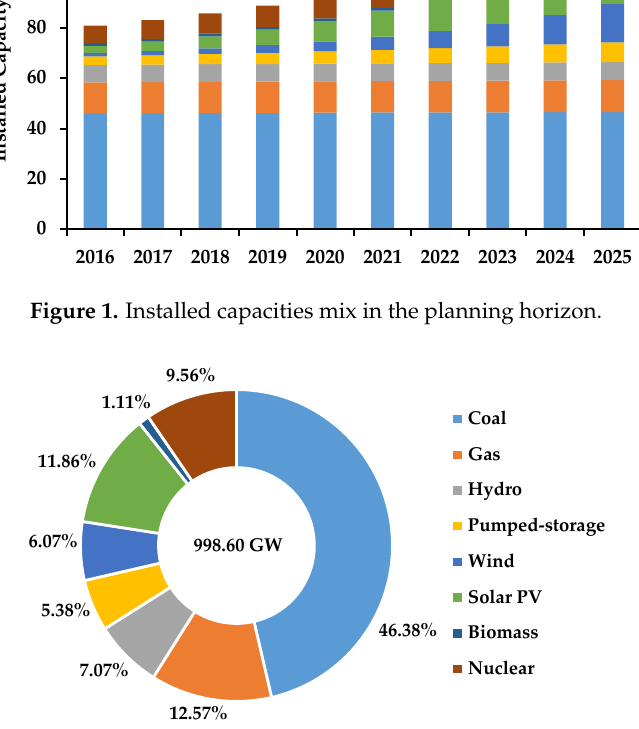
Figure 3. Power generation of different plants in the planning horizon.